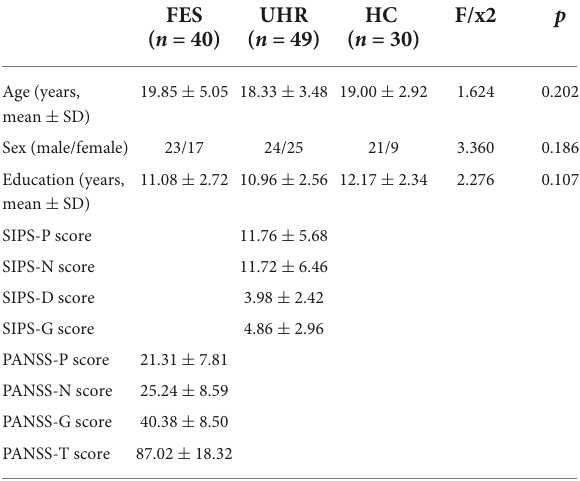
TABLE 1 Demographic and clinical